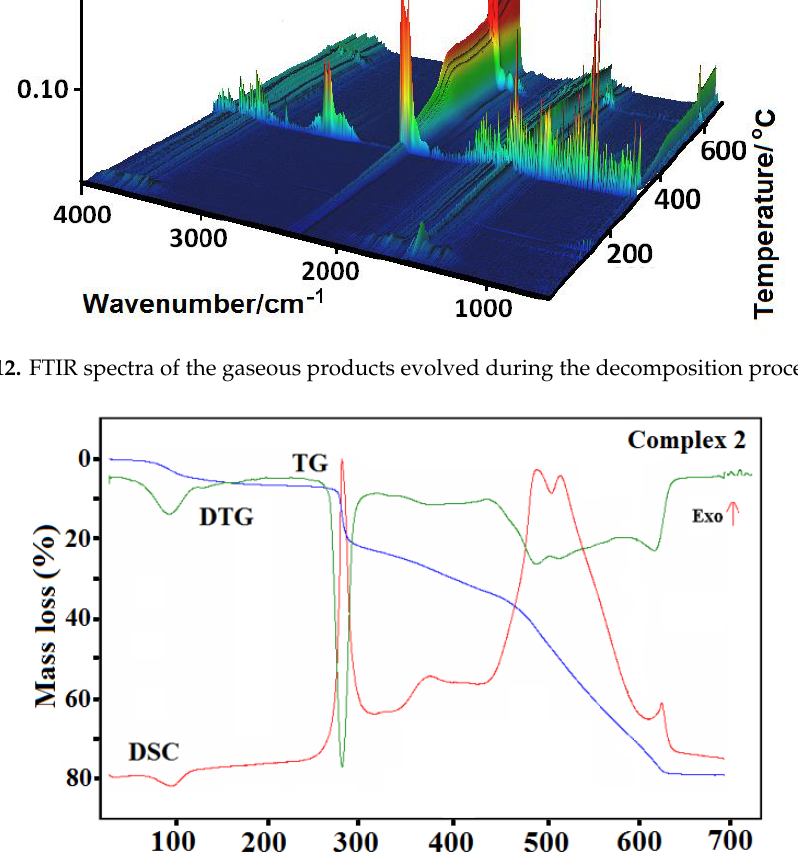
Figure 13. TG, DTG, and DCS curves of thermal decomposition of complex 2 in air. Crystals 2020 , 10 , x FOR PEER REVIEW